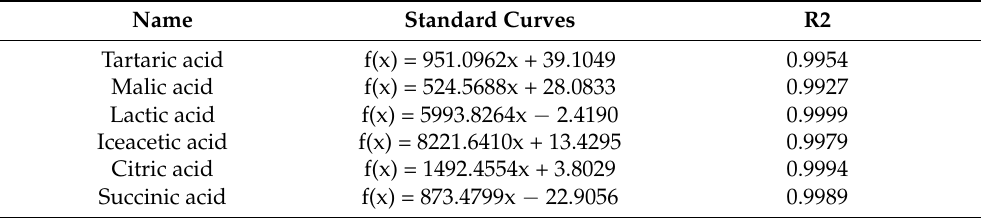
Table 1. Organic acid standard curve.